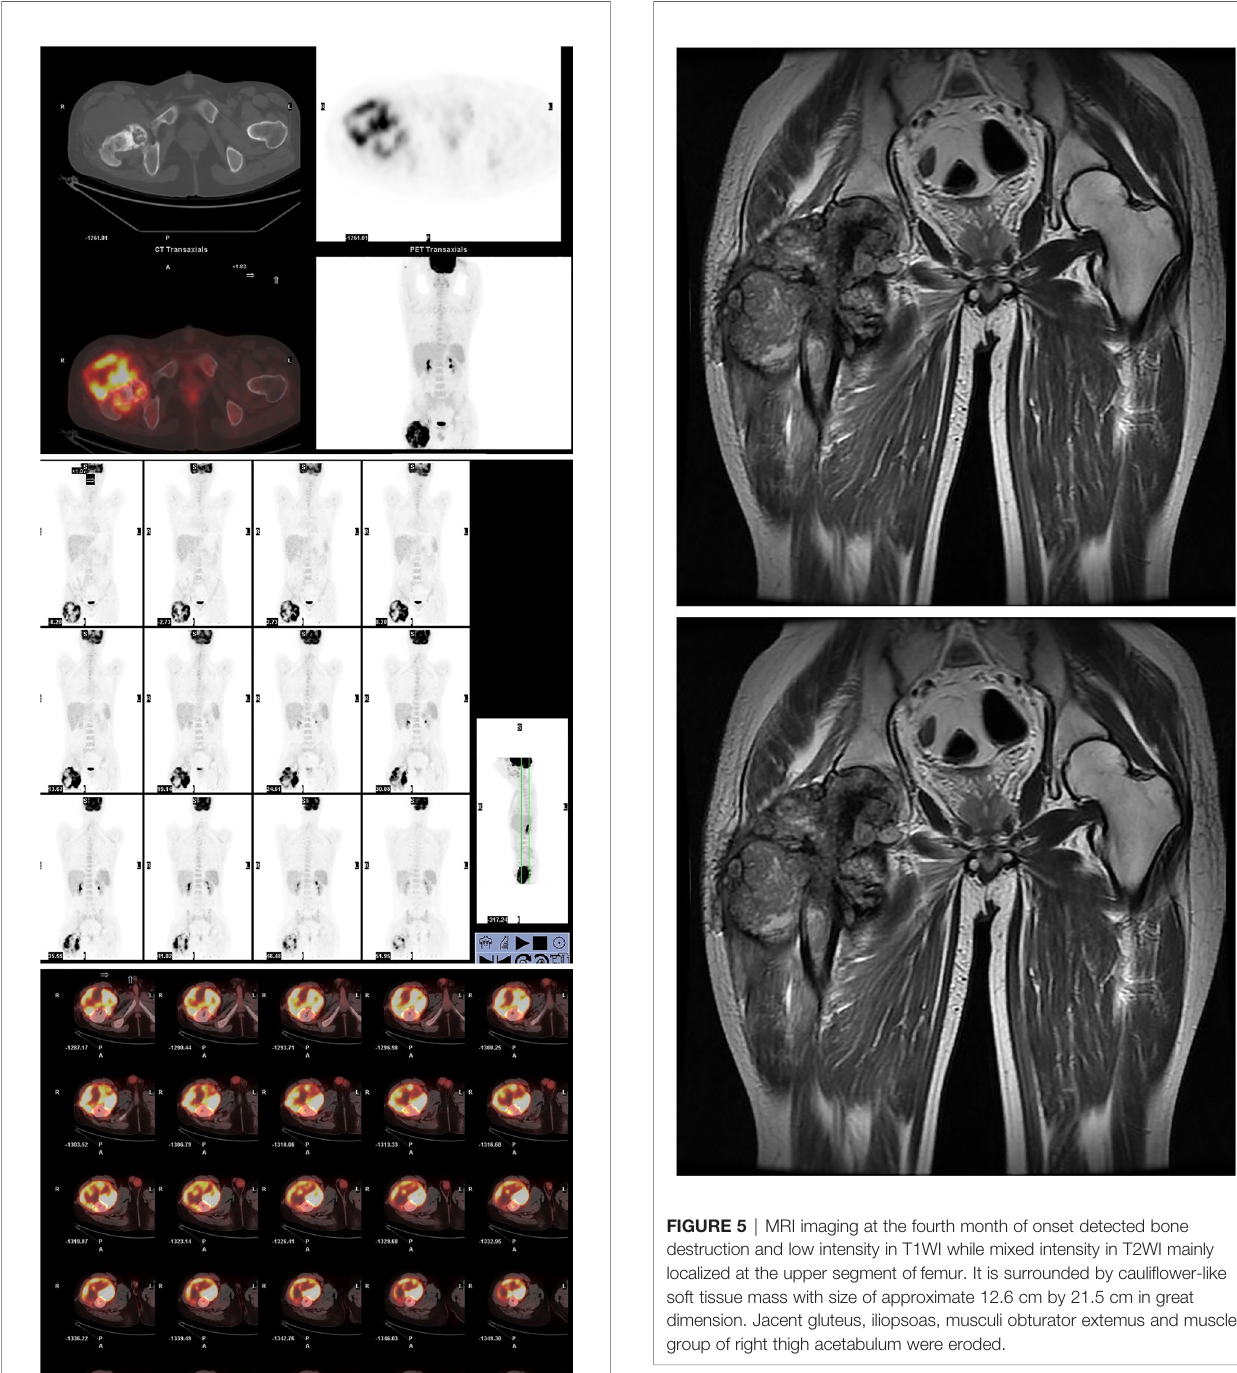
diffused large B cell lymphoma is the most common type, is relatively rare. Leval et al. (9) proposed that primary bone lymphoma may represent a tumor of post-germinal center B- cell bone lymphoma, because the bone marrow is the normal site of homing of plasma cells which functionally is de fi ned as terminally-differentiated, immunoglobulin(Ig)-secreting post- germinal center B-cell (10).